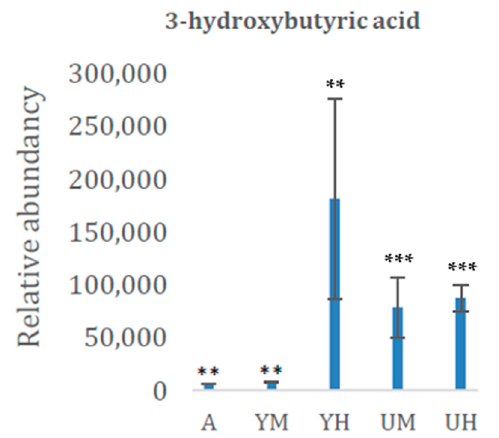
Figure 5. Relative content of 3-hydroxy butyric acid (means ± standard deviations, n = 8) in the Chlorella cultures after 8 days of cultivation in the following conditions: autotrophic (AUTO), mixotrophic with glycerol (GLY MIXO), heterotrophic with glycerol (GLY HETE), mixotrophic with glucose (GLU MIXO), heterotrophic with glucose (GLU HETE). ** and *** indicate significant differences in concentration relative to cultures grown in heterotrophic conditions with glycerol according to Student’s t -test at p < 0.01 and 0.001, respectively.